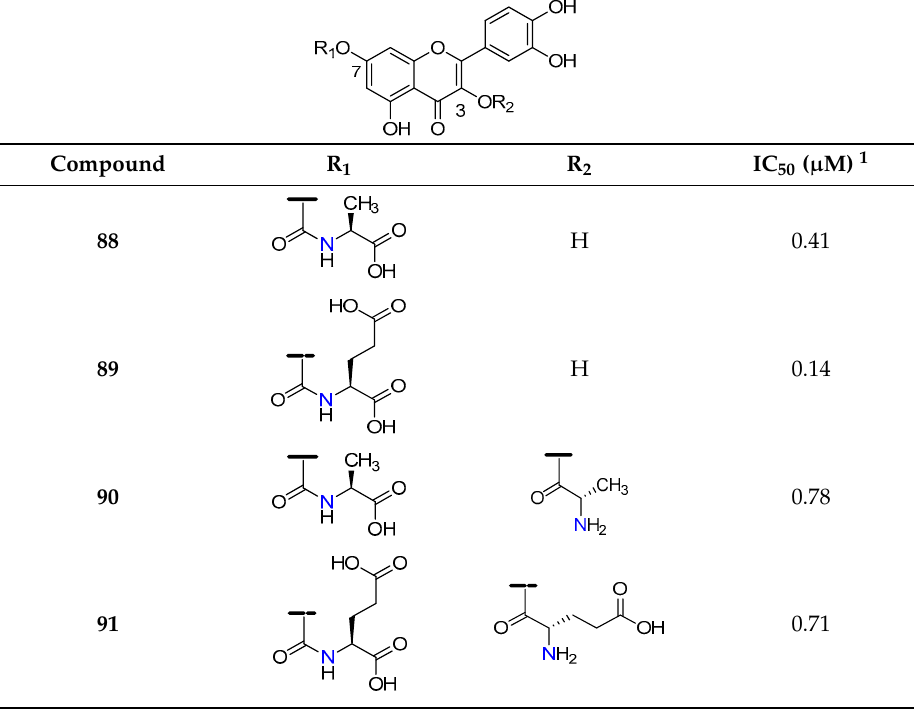
Table 9. P-gp modulation activities of quercetin derivatives 88 – 91 in MES-SA/Dx5 cell line [118].